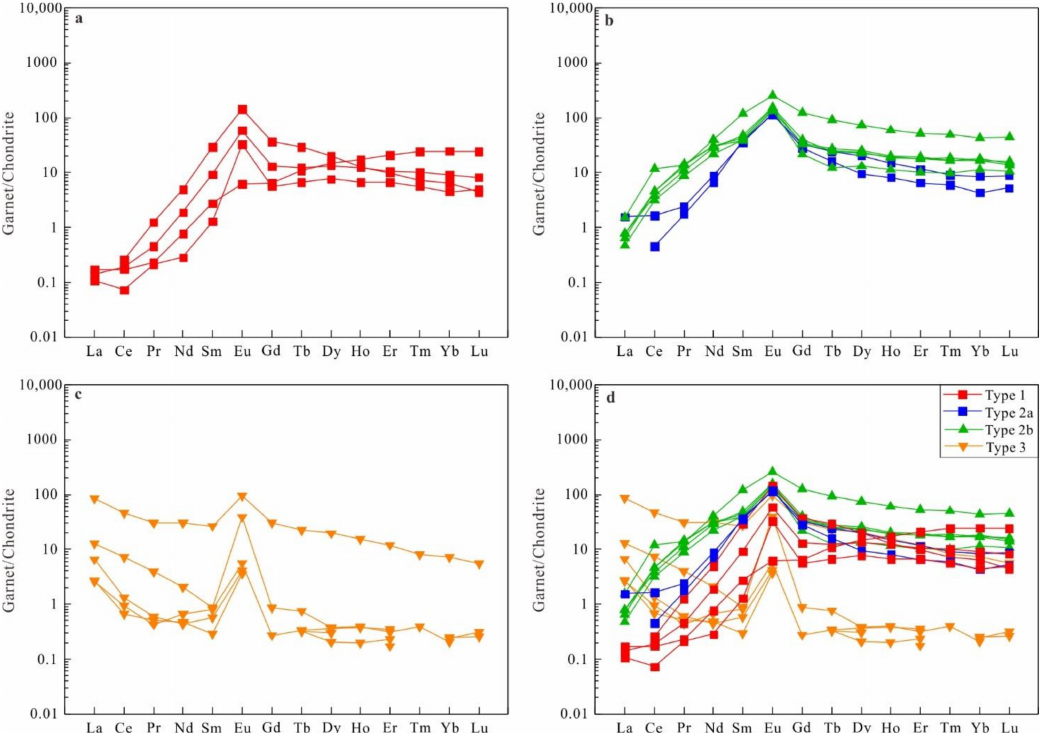
Figure 11. Chondrite-normalized REE patterns of different garnets from the Laoshankou deposit. ( a ) Type 1 garnet; ( b ) Type 2a and Type 2b garnets; ( c ) Type 3 garnet; ( d ) incorporation of different types of garnet. Normalization values are from